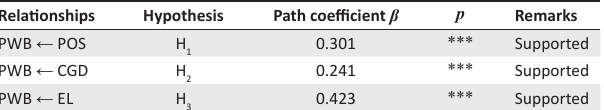
FIGURE 2: The final structural model of the TABLE 4: Summary of the hypotheses testing. Relationships